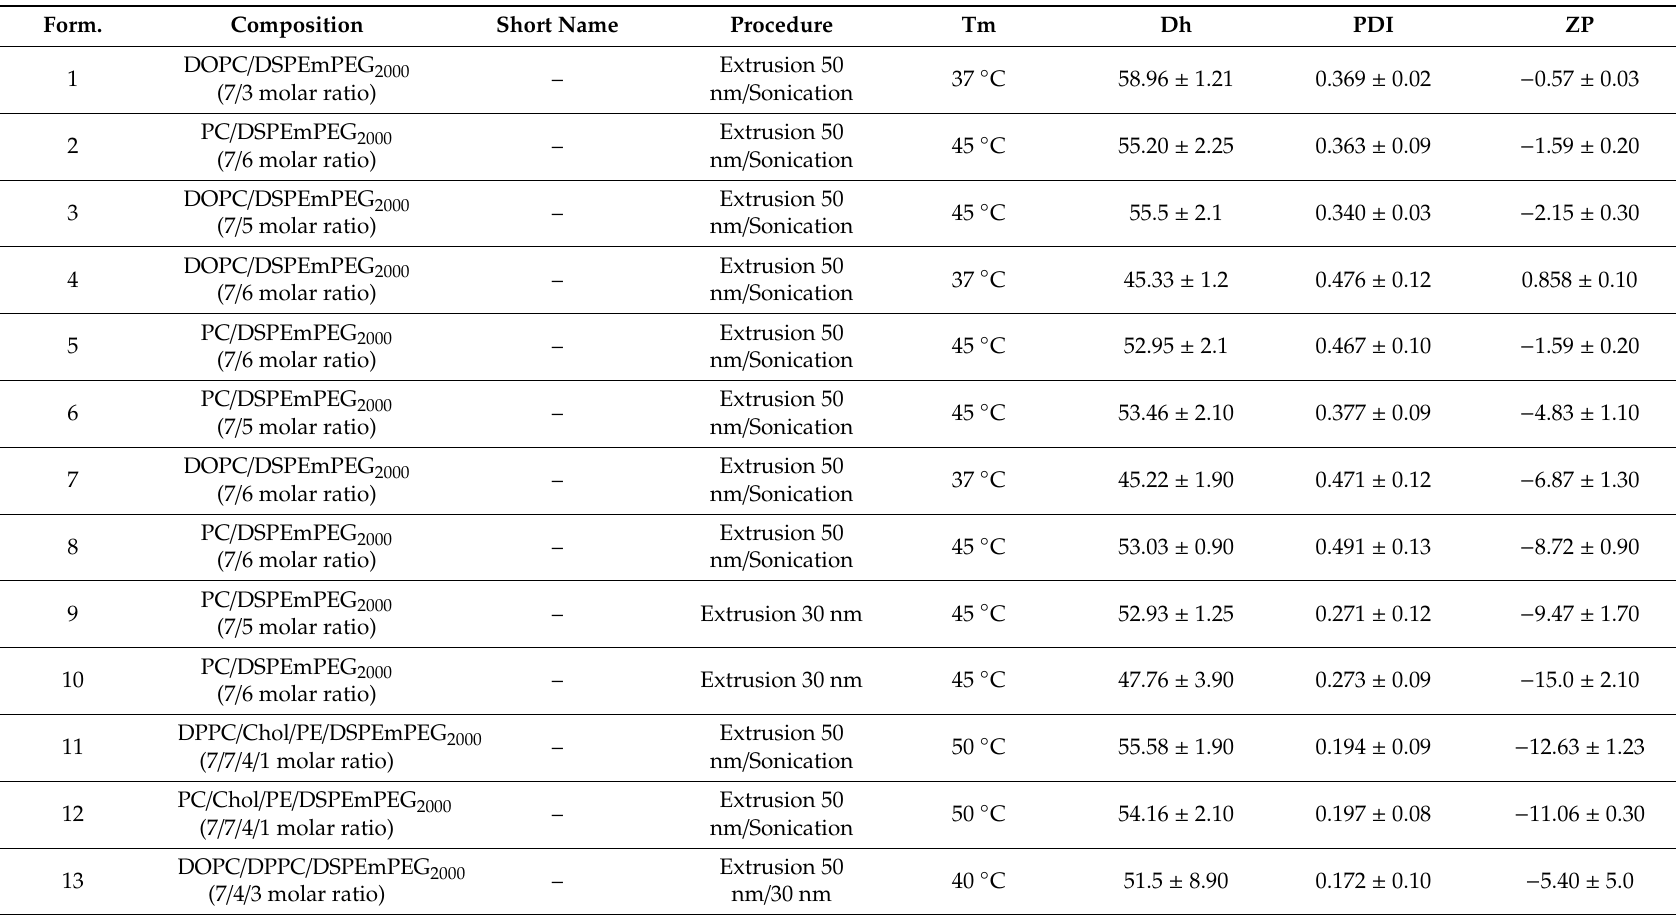
Table 1. Liposomal formulations. Hydrodynamic diameter (Dh) and polydispersity index (PDI) were measured by dynamic light scattering (DLS). ζ –potential was measured by laser Doppler electrophoresis (LDE). Experiments were performed in three independent replicates. Results are the average of five measurements per replicate (mean ± standard